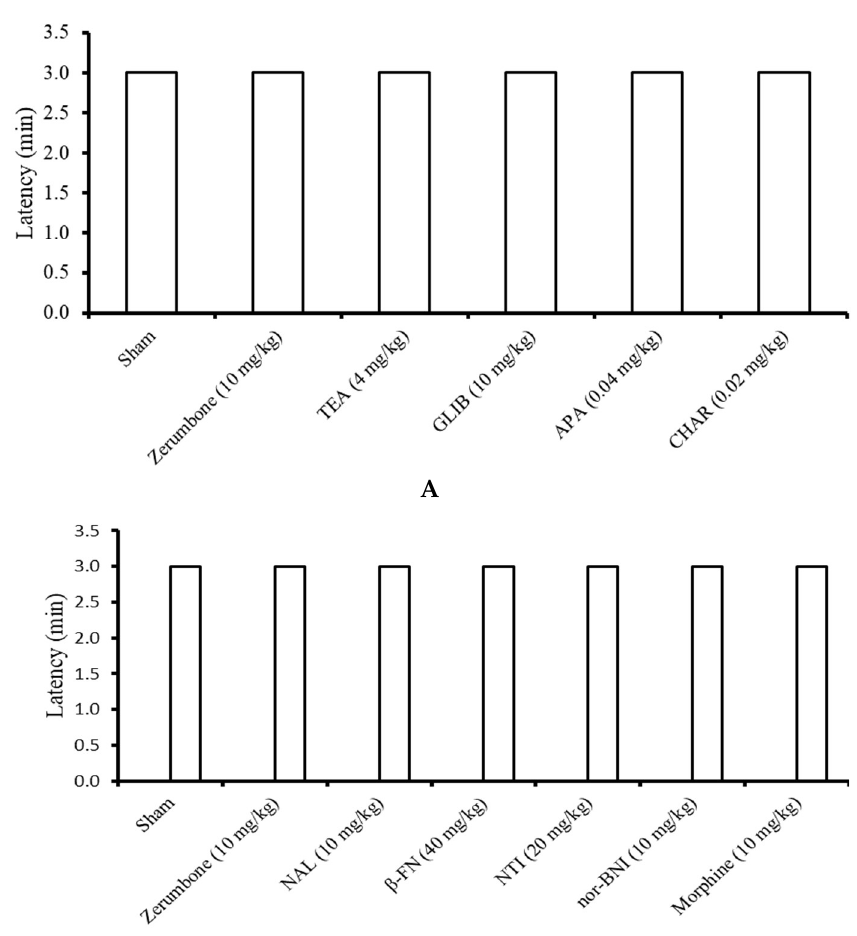
Figure 9. Effects of the treatments on the rota rod performance in mice following treatment with zerumbone, ( A ) potassium channel antagonists, and ( B ) opioid receptor antagonists. (TEA: Tetraethylammonium; GLIB: Glibeclamide; APA: Apamine; CHAR: Charybdotoxin; NAL: Naloxone; β -FNI: β -funaltrexamine; NTI: Naltrindole; nor-BNI: nor-binaltorphamine). Values represent the means ± SEM; n = 8 mice per group (one-way ANOVA followed by Tukey’s post hoc test).